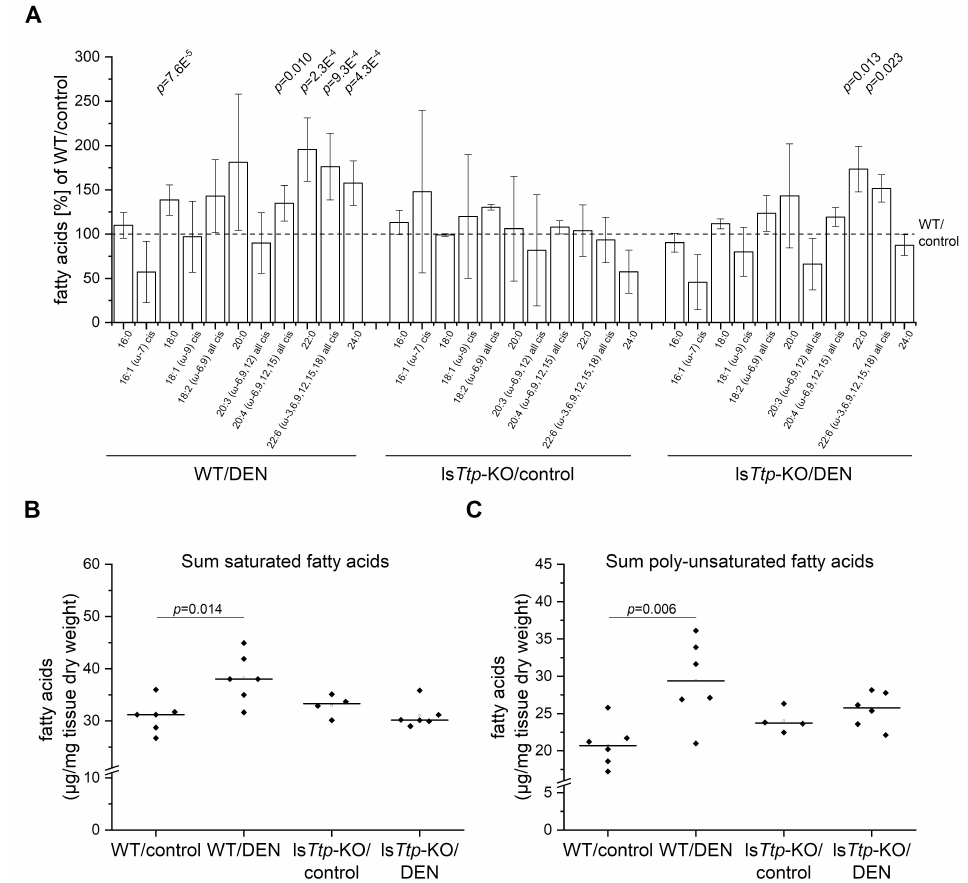
Figure 2. Hepatic fatty acid (FA) profile in short-term DEN-treated ls Ttp -KO mice. ( A ): Overview of hepatic FAs in the four comparison groups. The values for the represented FAs are normalized to the corresponding FA in the WT / control, which is set to 100% and is illustrated by the dashed line. Statistical di ff erences refer to the respective control, which means that WT / DEN is compared with the WT / control, and ls Ttp -KO / DEN is compared with the ls Ttp -KO / control. Error bars indicate SD. Graphs for single FAs are shown in supplementary Figure S1. ( B ): Sum-saturated FAs (14:0, 16:0, 17:0, 18:0,